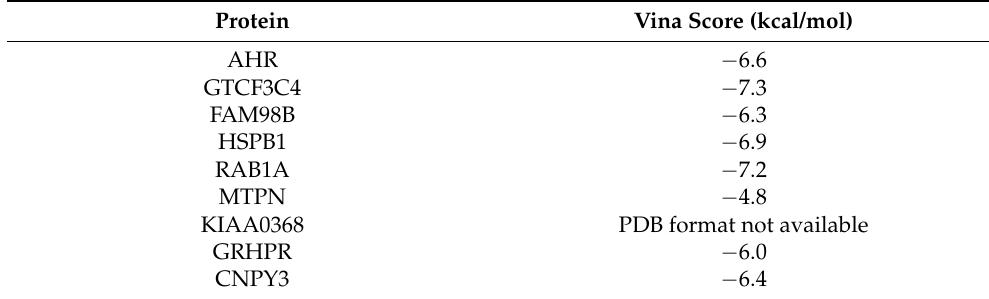
Table 1. Affinity scores obtained by molecular docking for TCDD and the targets obtained by PISA assay and the well-known target, AHR.